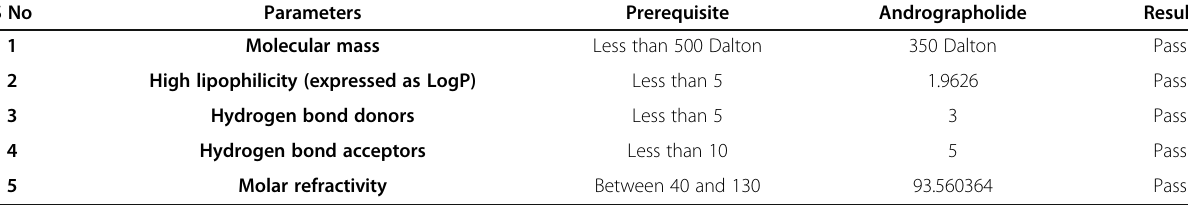
Table 1 Lipinski rule of 5: Determination of drug likeliness of andrographolide